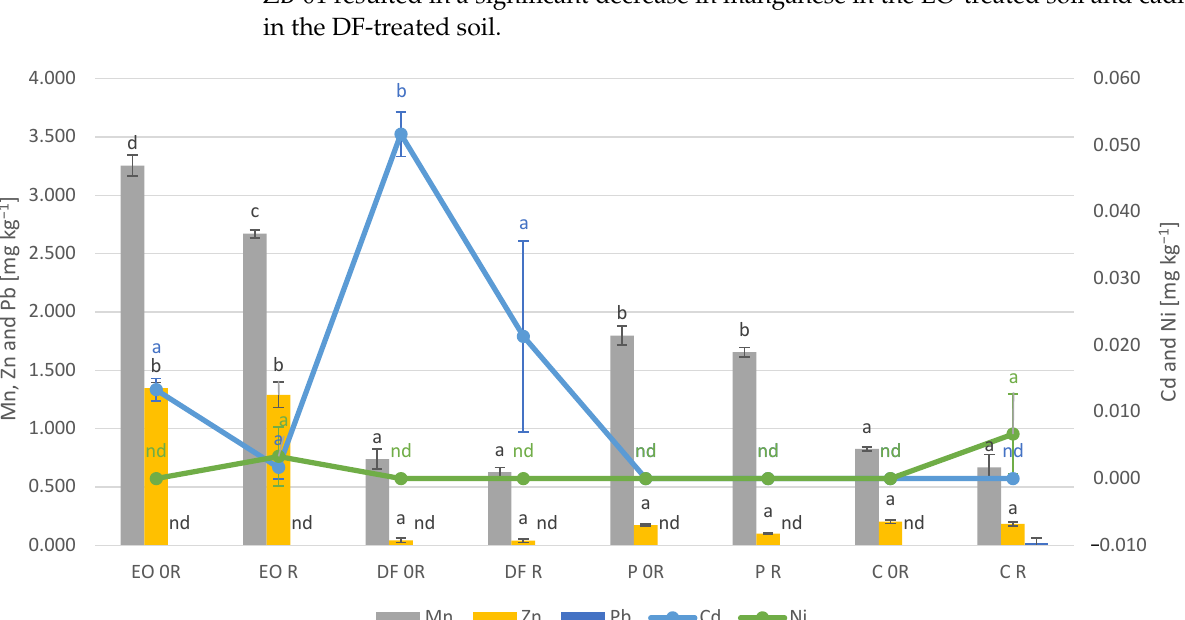
Figure 4. The effect of PDSs and bioremediation on the content of heavy metals in the experimental soils (potentially bioavailable elements). The means ( ± SE) for individual elements that are marked with the same letters did not differ